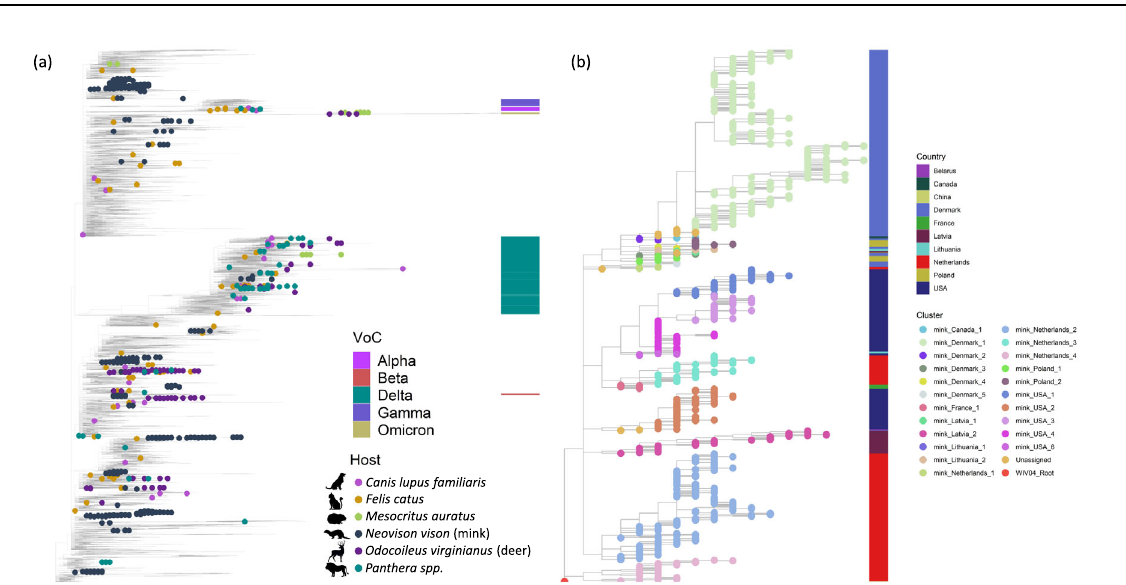
Fig. 1 Multiple emergences and onward transmission of SARS-CoV-2 in animals. a Subsampled Audacity tree ( n = 16,911) comprising 10 human isolates per PANGO lineage, and all animal isolates shown in Table 1, illustrating the global context of SARS-CoV-2 infections in animals. b Maximum-likelihood tree of all 928 mink isolates, with manually curated cluster names (see “ Methods ” ) and country of isolation